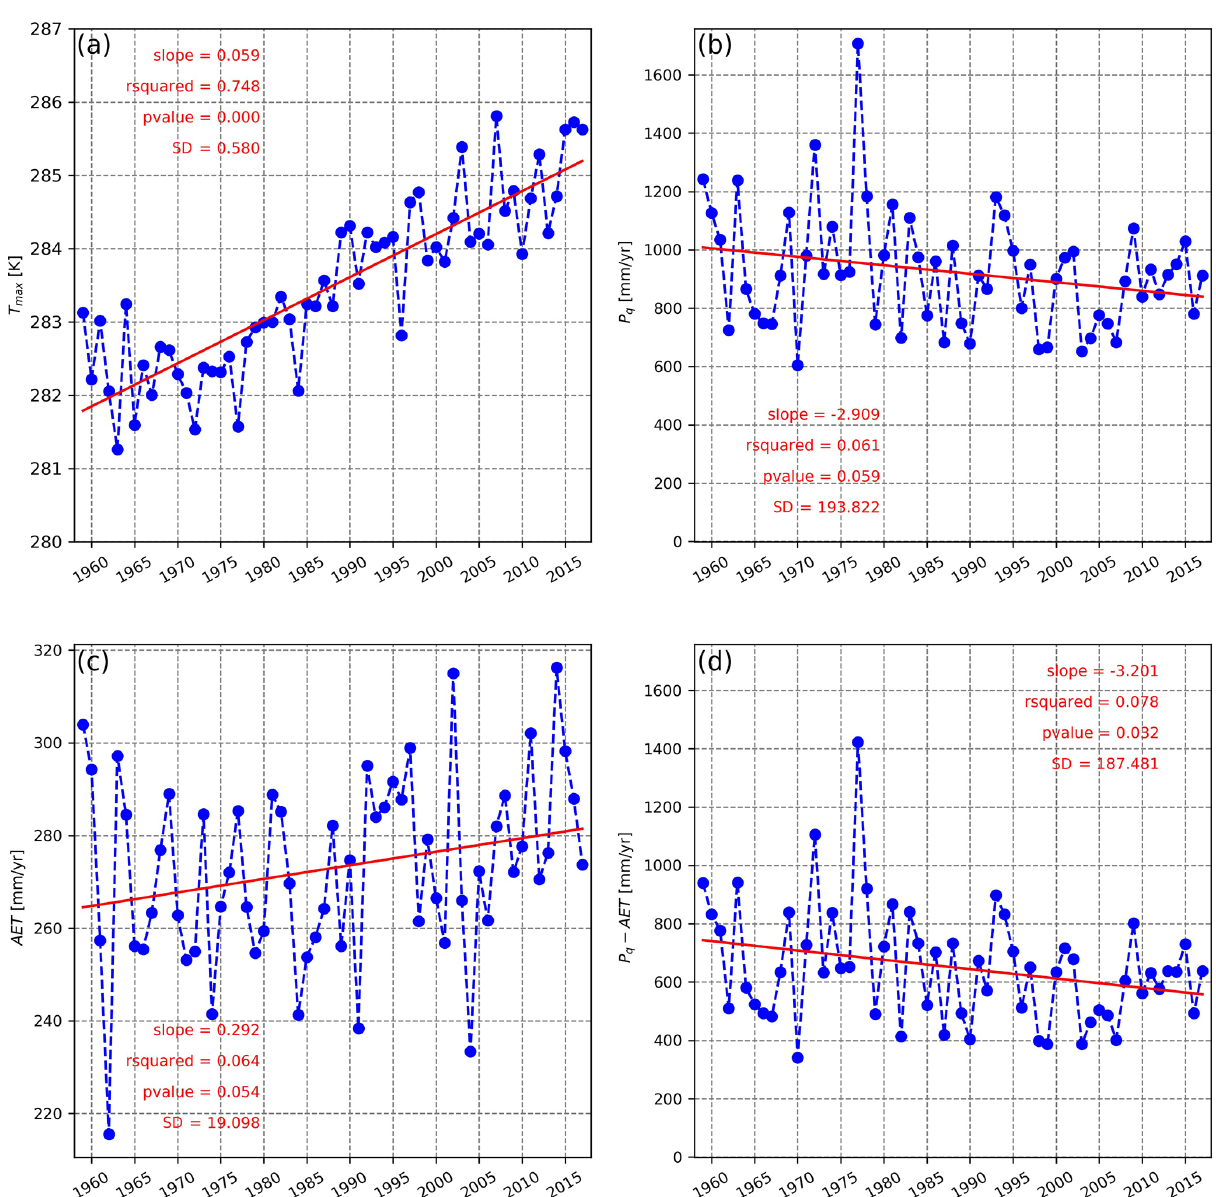
Figure 3. Hydrological year time series of T max (a) , P q (b) , AET (c) and drainage (d) along with their trends, R 2 , p values and standard deviations, for the time period from 1959 to 2017, at the Turin cross-section 66 (the location is shown in Fig. 1) of Dora Riparia river basin (average at the catchment level). The standard deviation, evaluated considering the detrended time series, provides a quantification of interannual